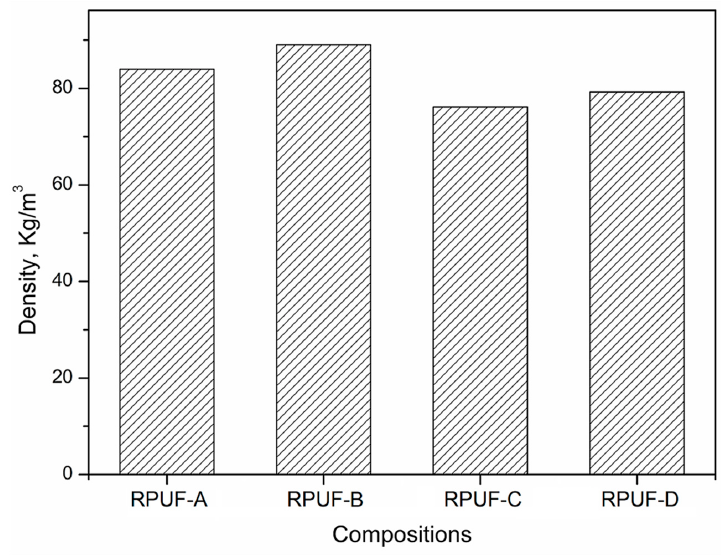
Figure 6. The apparent density of prepared RPUFs.